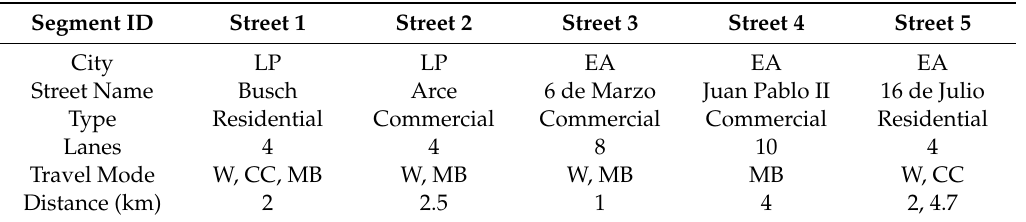
Figure 1. Map of La Paz and El Alto City in Bolivia with the selected commuting routes highlighted in the blue line. Time spent and distance traversed per mode of travel in each street segment is enumerated for walking, cable car, and microbus rides, respectively. Table 1. Characteristics of the selected commuting routes in La Paz and El Alto City,